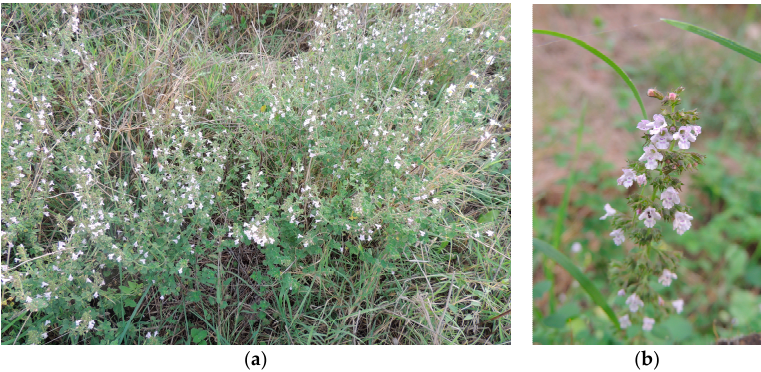
Figure 1. ( a ) C. nepeta (L.) Savi subsp. glandulosa (Req.) Ball (CG) in its natural habitat in Tarquinia countryside; ( b ) CG, close-up (photo: Mijat Božovi ć ).